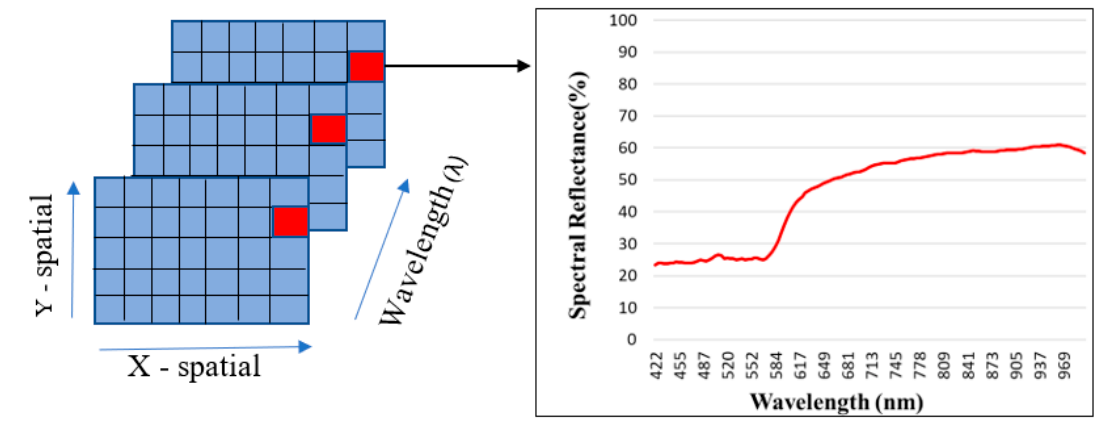
Figure 2. Representation of hyperspectral image as a function of wavelength and image data structure.